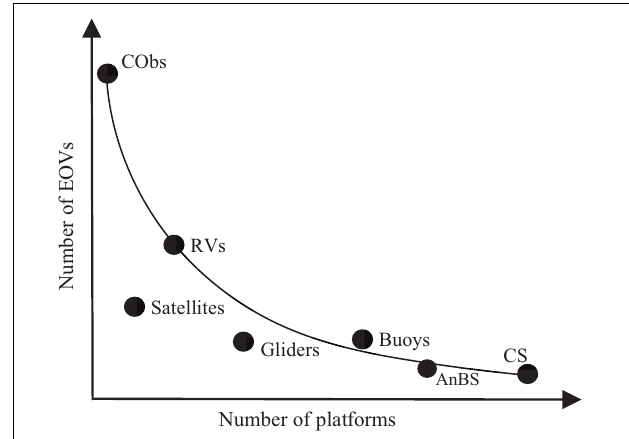
FIGURE 1 | Schematic of the number of observed essential ocean variables (EOVs) from a specific platform vs. the available number of these platforms. A distributed system for observations will use all its nodes to deliver fit- for- purpose information, products and services. Cobs, cabled observatories; RVs, research vessels; AnBS, animal borne sensors; CS, citizen science. Note: additional dimensions could be included in the plot, e.g., observation range, cost of the platforms,